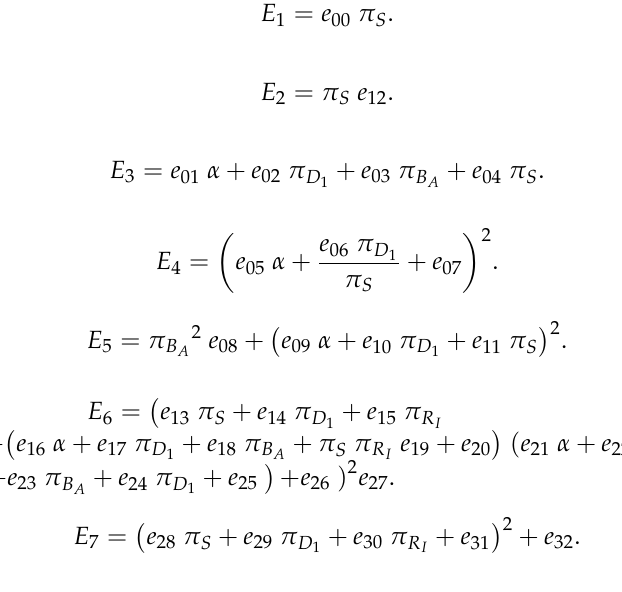
Table A4. Rounded values of the constant for Equation